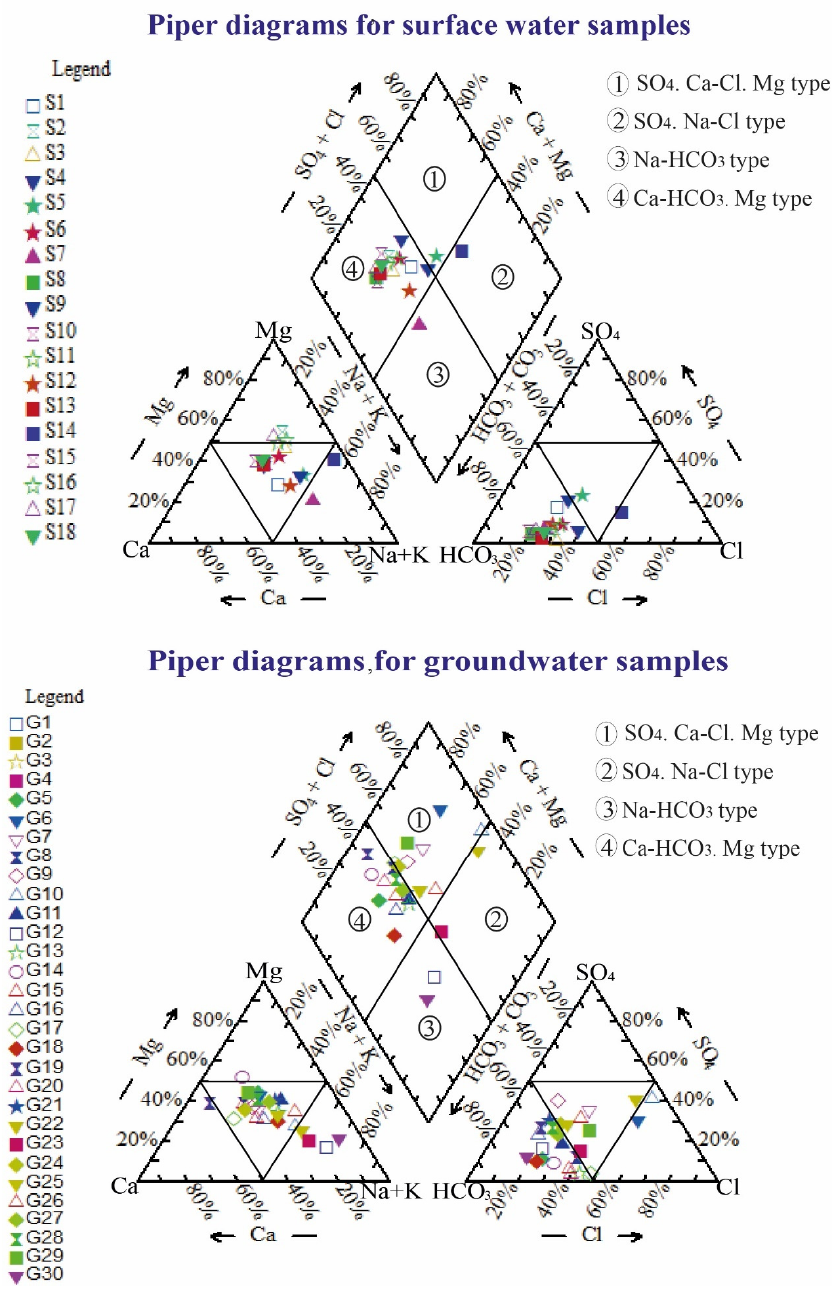
Figure 4. Piper’s diagram showing classi fi cation of the water samples in the study area.